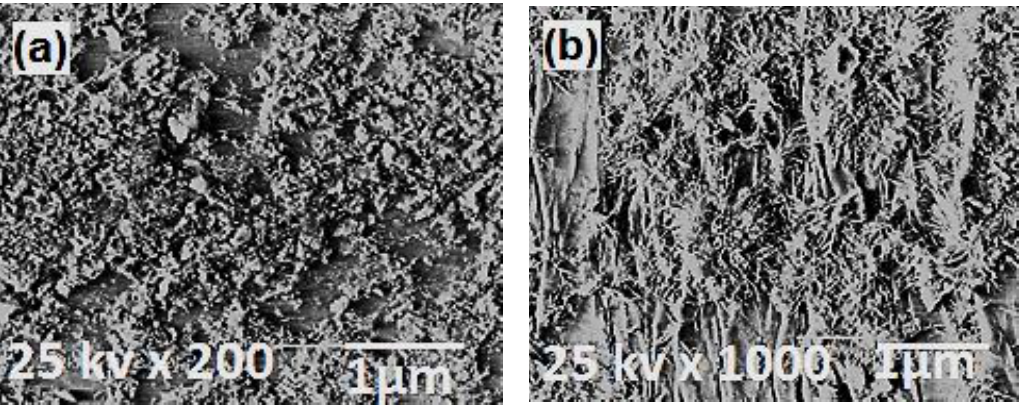
Figure 5. SEM graphs of ( a ) PES-WO 3 and ( b ) PES-ZnO nanocomposites.